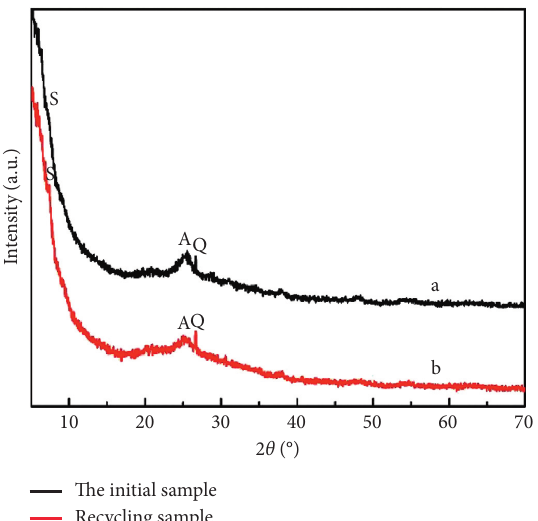
Figure 29: XRD phase analysis Atlas of composites (a: initial sample; b: recycling sample after the cycle; S: sepiolite; A: ZnO; Q: